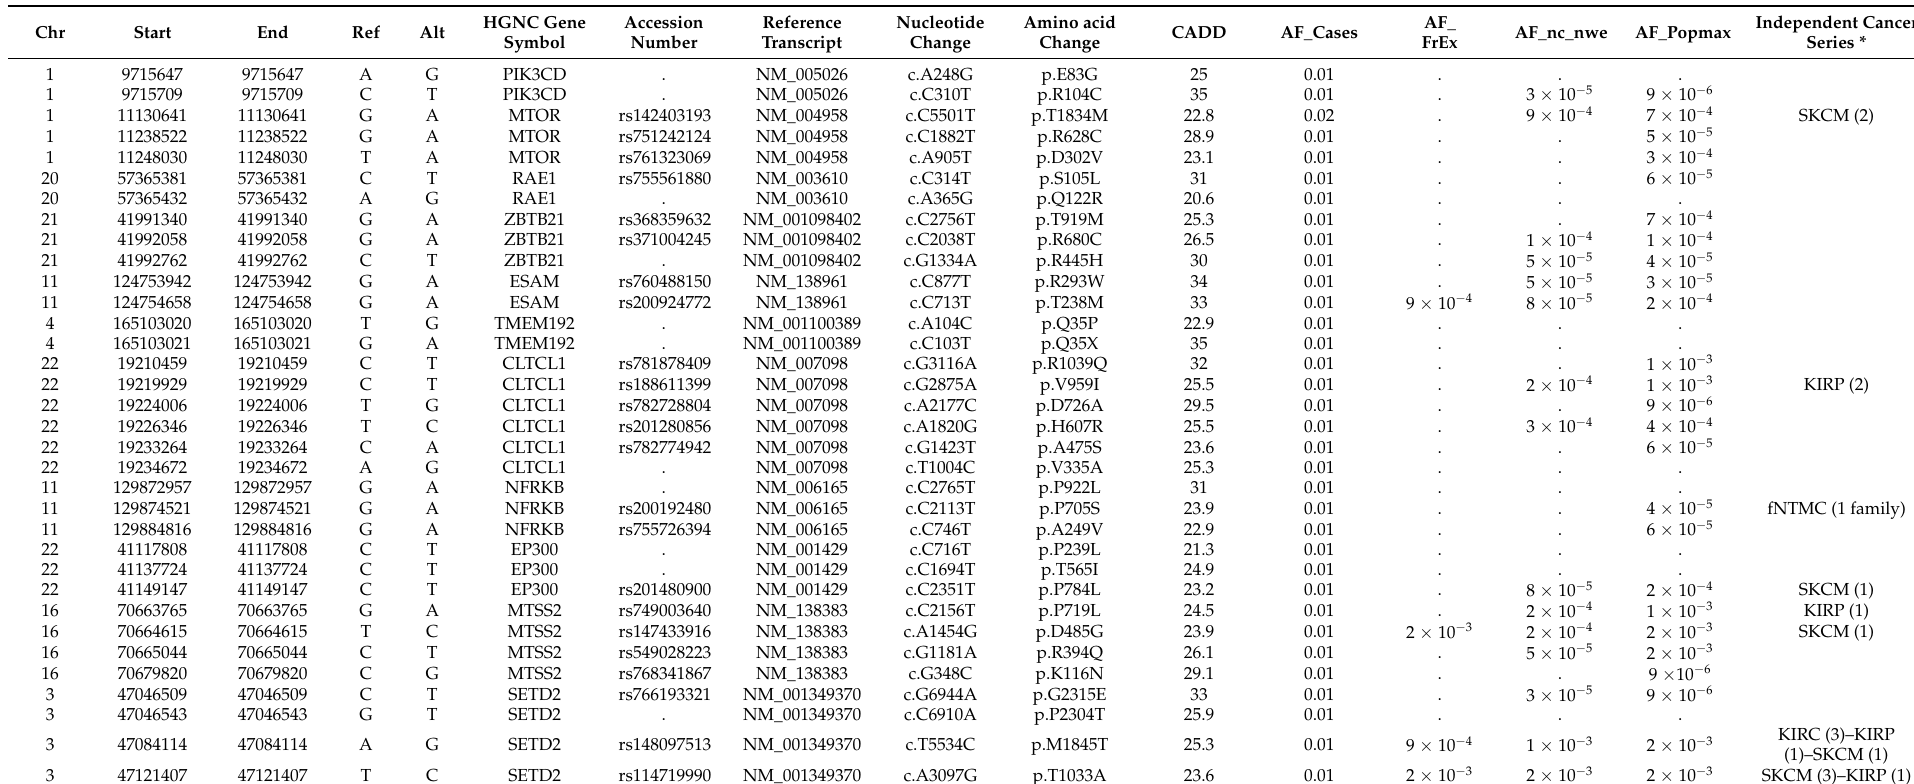
Table 4. Set of 41 rare deleterious variants observed in the 13 candidate CMM and/or RCC susceptibility genes identified by gene-based case-control enrichment